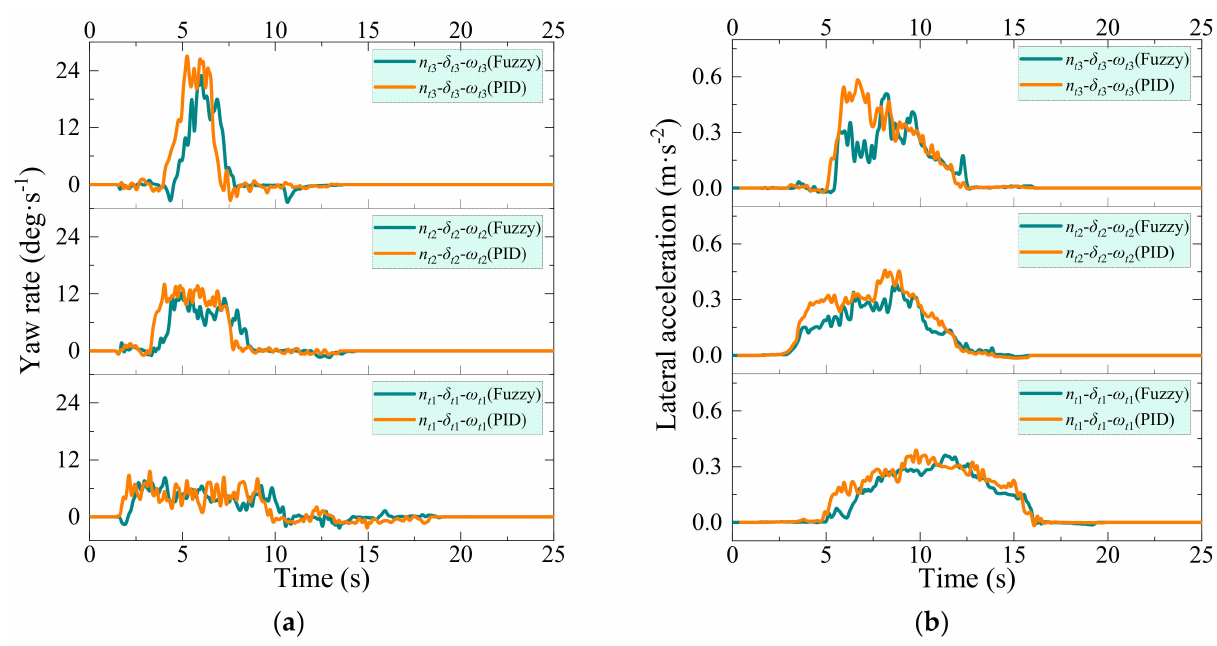
Figure 15. Kinematic parameter variation curve: ( a ) changes in yaw rate; ( b ) changes in lateral